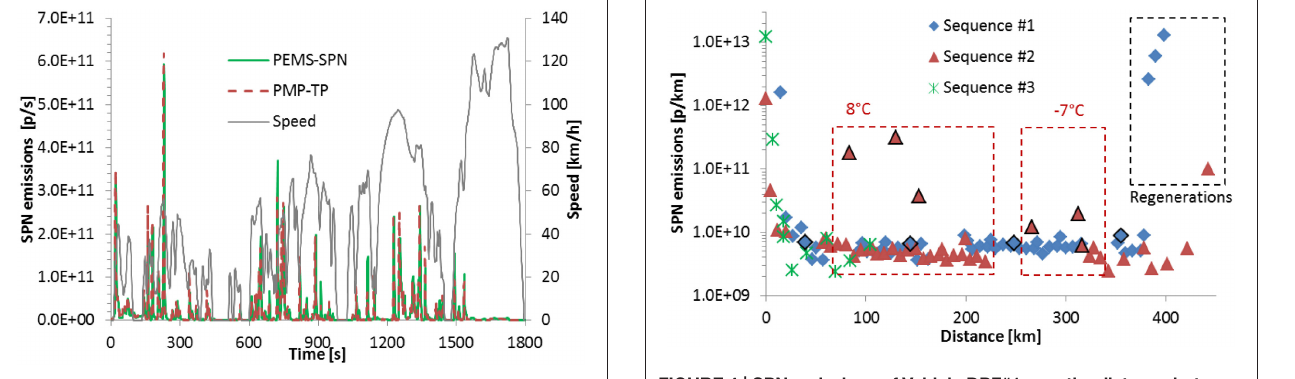
FIGURE 3 | Real-time comparison of PEMS-SPN and PMP-TP measurements of Vehicle GDI #2 over one WLTC in the laboratory. Both systems were connected to the tailpipe.